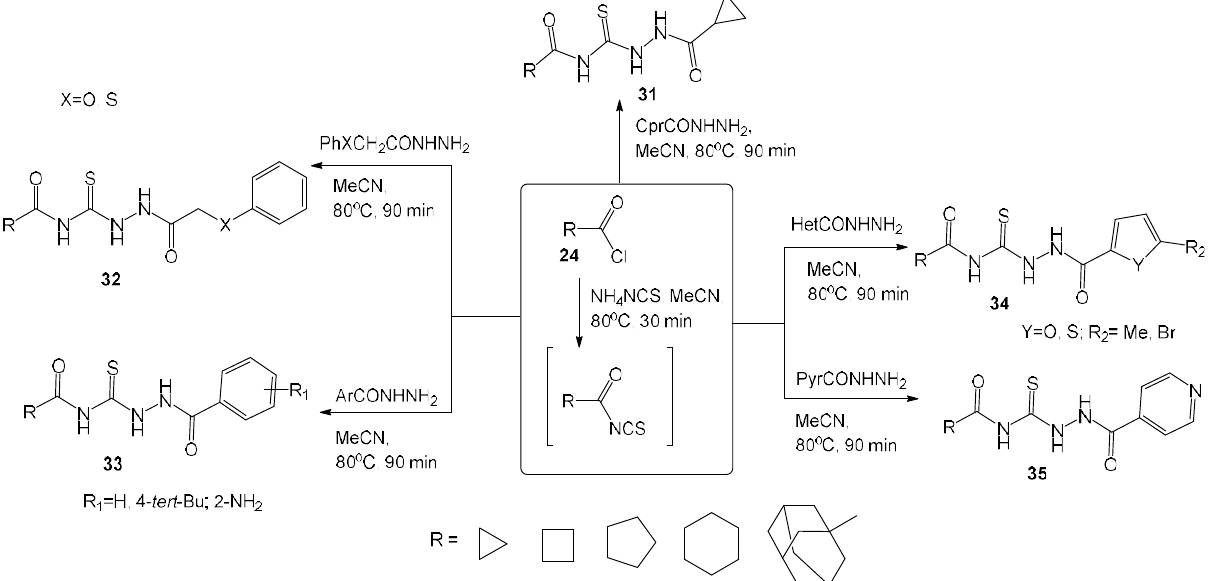
Fig. 10. Structural modification of diacyl thiosemicarbazides to target anticonvulsants